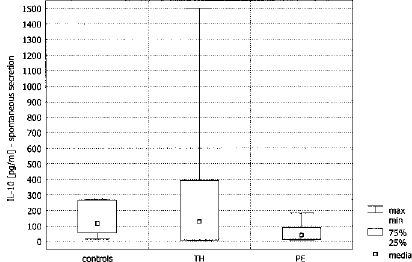
FIG. 7. Comparison of IFN g spontaneous secretion in healthy pregnant women (controls) ( n = 11), and pregnant women with transient hypertension (TH) ( n = 17) and pre-eclampsia (PE) ( n = 21). Statistically significant are controls and TH ( p < 0.03).